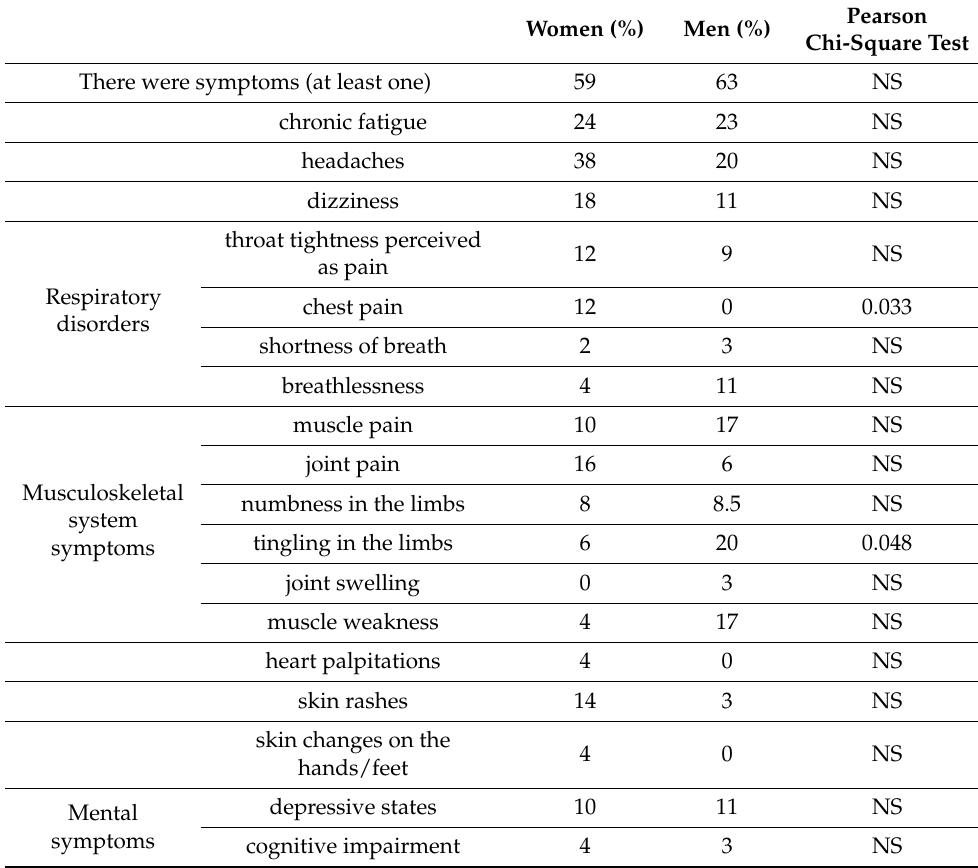
Table 1. Symptoms of infection that occurred in the respondents during the last 6 months before the control